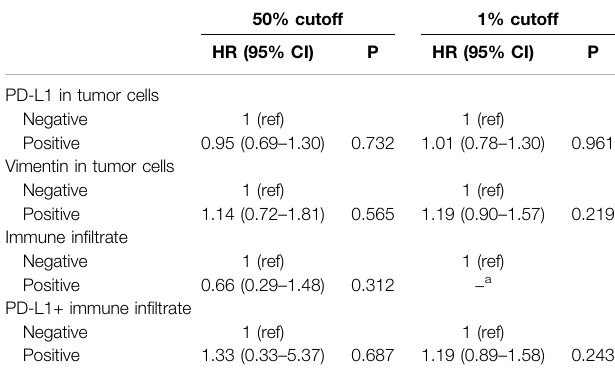
TABLE 3 | Distribution of biomarkers ’ values with different cutoffs.